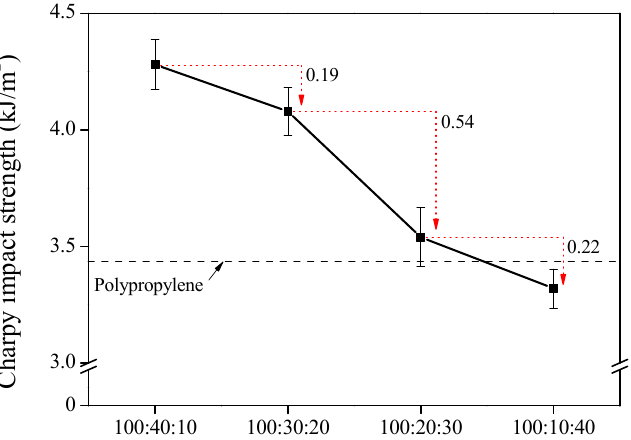
Figure 5. Charpy impact strength of the composites with different mixing ratios of polypropyl- ene:carbon fibers:graphite flake. lene:carbon fibers:graphite flake.